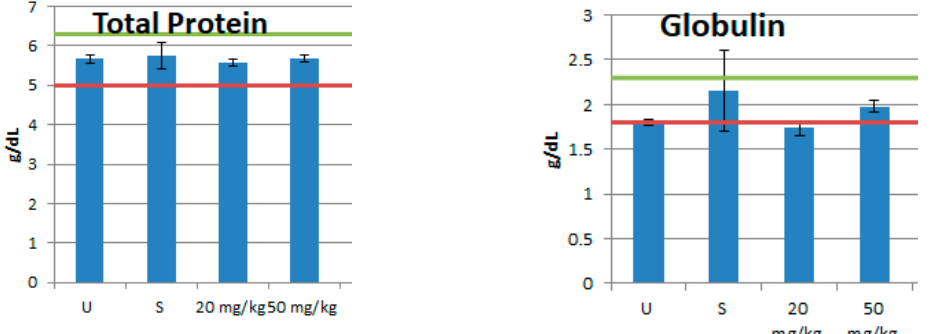
Figure 2. In vivo toxicity assessment of the compound 18 . Two doses (20 and 50 mg/kg) were administered intraperitoneally (IP) in CD-1 mice (n = 5 for each dose). Blood samples were collected 24 h later and tested by 14 parameters for organ functions. The red and green lines indicate the normal ranges for the assays. U, untreated animals; S, animals injected with saline (vehicle control).